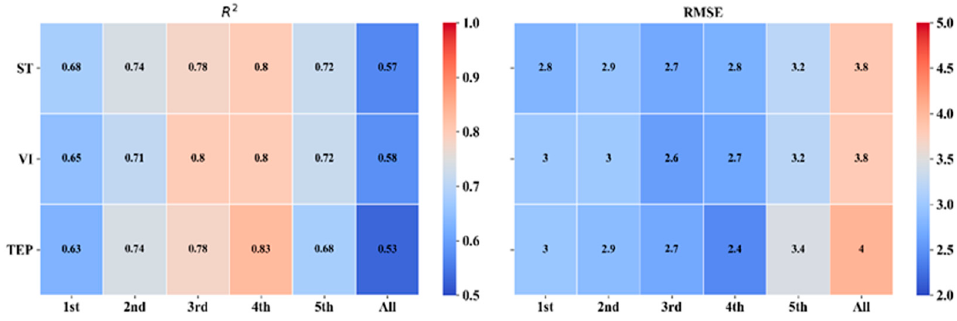
Figure 4. R 2 and RMSE of validation datasets at different growth stages. Spectrum translation (ST), vegetation indices (VIs), and three edge parameters (TEP).